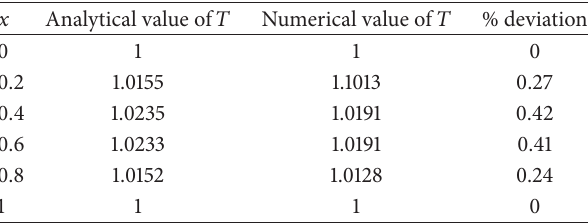
Table 2: Comparison between analytical and numerical values of dimensionless temperature 𝑇 (Le = 0.233 , 𝛽 = 4.287 , 𝛾 = 13.6 , and 𝜙 2 = 30000